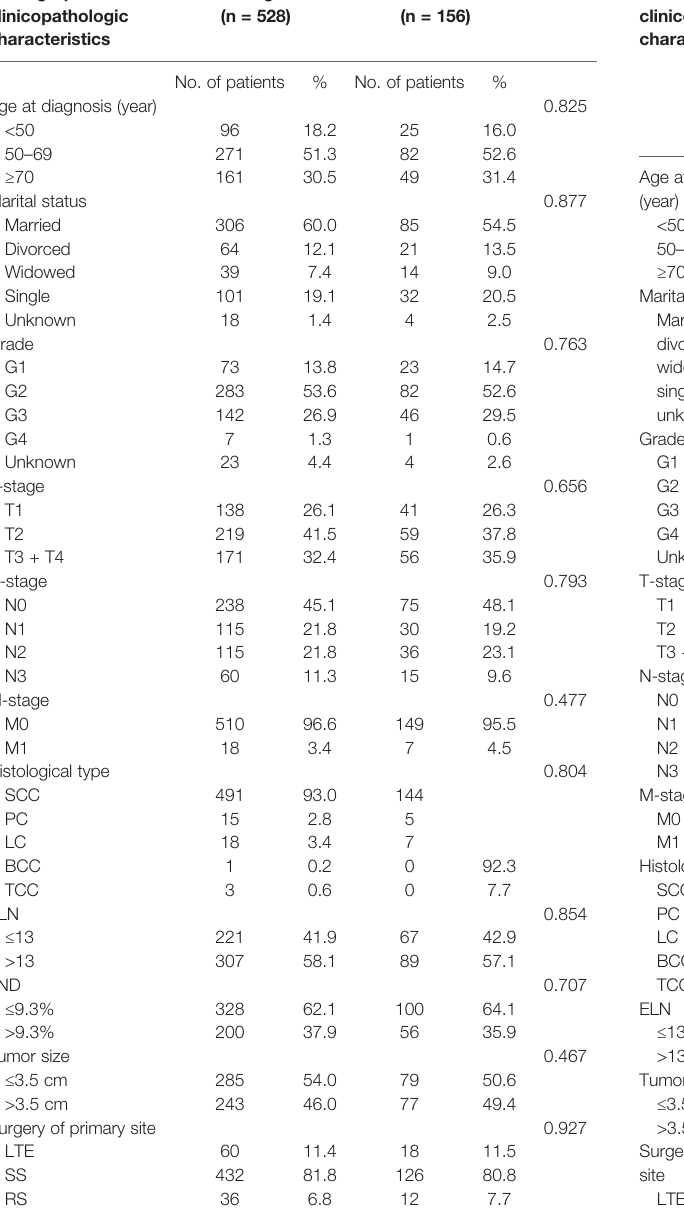
TABLE 1 | Demographics and clinicopathological characteristics of patients in training cohort and validation cohort. Demographics and clinicopathologic characteristics